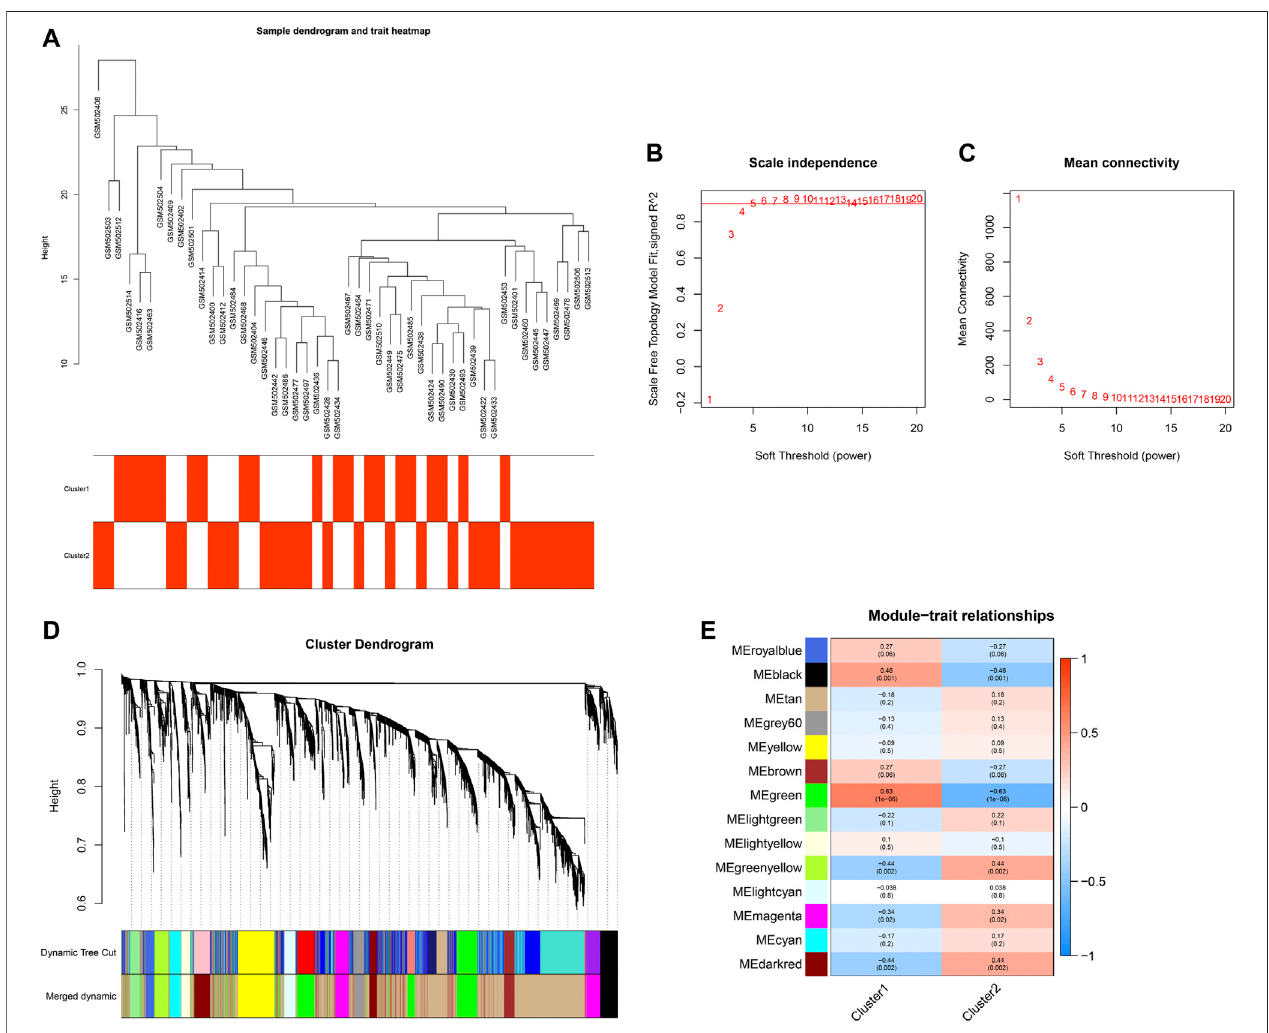
FIGURE 6 | Establishment of a co-expression network. (A) Sample dendrogram and trait heatmap. (B,C) Scale independence and mean connectivity under diverse soft-thresholding powers. (D) Co-expression modules for each gene under the hierarchical clustering tree are assigned diverse colors. The dynamic tree cut corresponds to the original modules, and merged dynamic corresponds to the merged modules fi nally identi fi ed. (E) Heatmap of the relationships between co- expression modules and clinical traits. The number indicates the correlation coef fi cients between co-expression modules and clinical traits, and the number in parentheses indicates the corresponding p